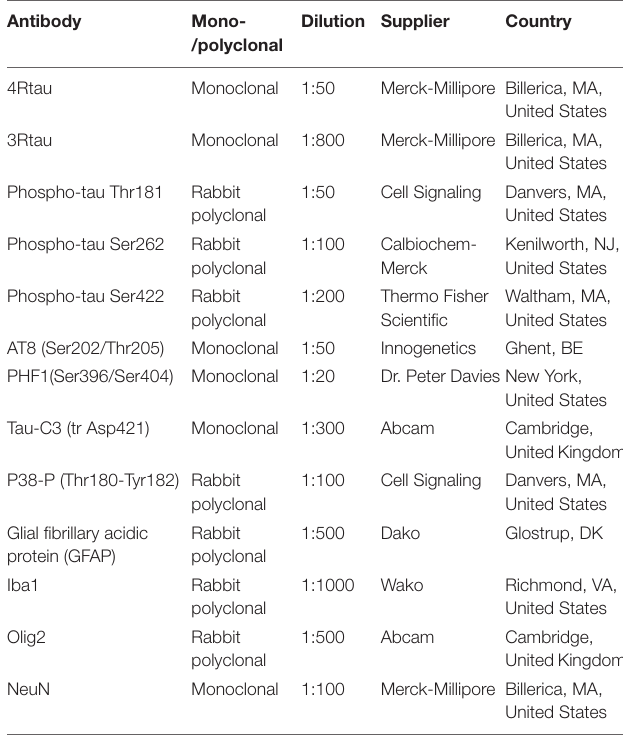
TABLE 1 | Characteristics and dilutions of the antibodies used for immuno-histochemistry and immunofluorescence. Antibody Mono- Dilution Supplier /polyclonal